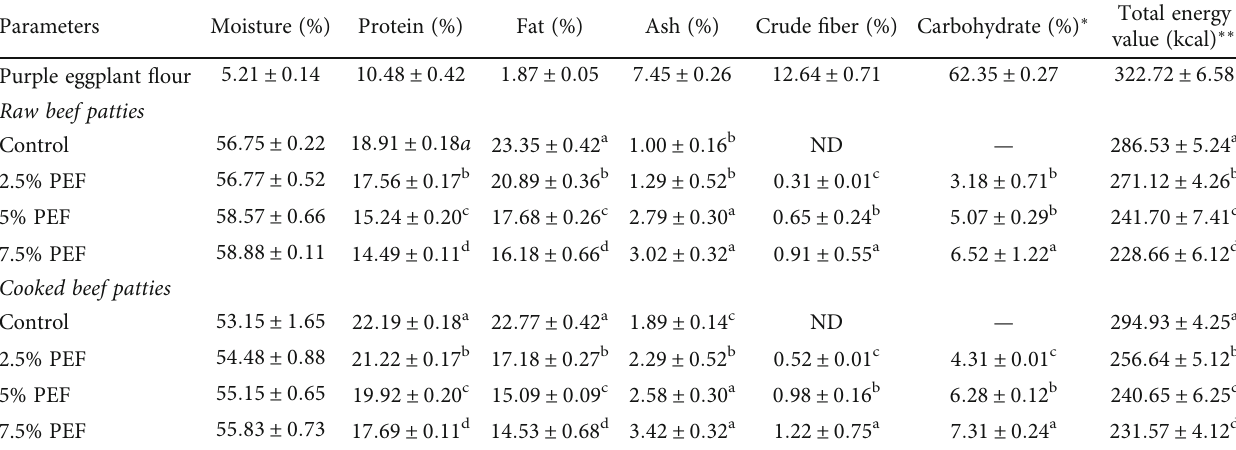
Table 2: Nutritional compositions of PEF, raw, and cooked beef patties containing di ff erent concentrations of PEF (% wet basis). Parameters